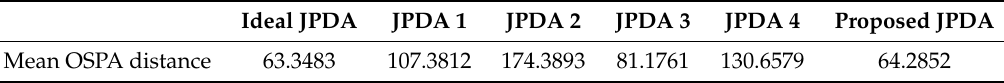
Table 1. Mean OSPA distance of 200 Monte-Carlo